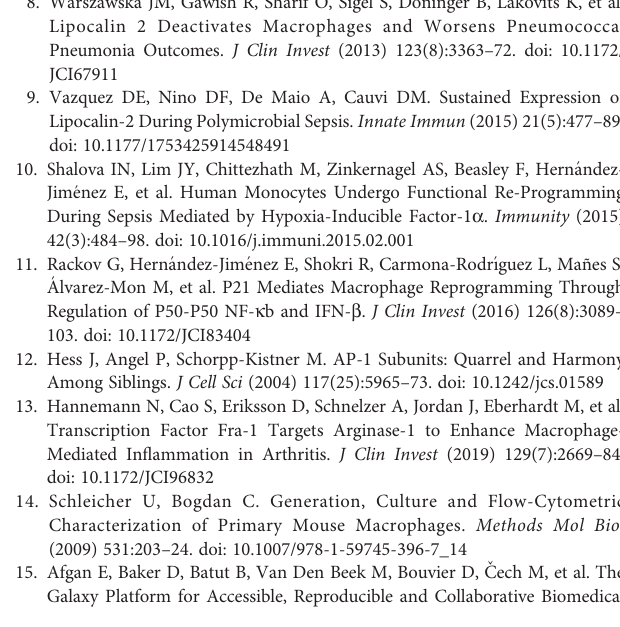
Supplementary Figure 2 | Follicular area is not signi fi cantly altered in the immunosuppressive phase of sepsis in Fosl1 Δ Mx mice compared to littermates. Representative H&E microscopy images and quanti fi cation of follicular area in the spleen of Fosl1 Δ Mx and the littermate mice after once (naïve) or twice (tolerant) stimulation of LPS. Scale bar = 200 m m. Graph points indicate individual mice. Data are shown as mean ± s.e.m. *p < 0.05 by one-way ANOVA with Sidak ’ s multiple comparisons test. Supplementary Figure 3 | Uncropped blots results of ( Figure 3B ) Western blot detection of FRA-1 protein after LPS stimulation in littermate control and FRA-1 de fi cient BMDM in both naïve and tolerant state. GAPDH was used as loading control. Supplementary Table 1 | Primers sequences used for Real-Time PCR and